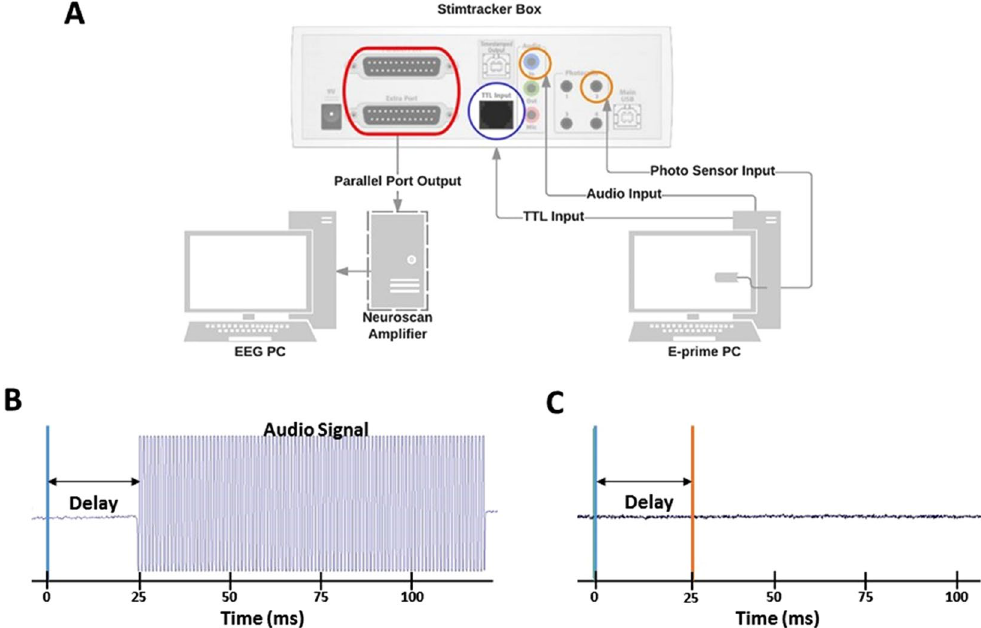
Figure 2. Measuring Time Delays in Task-based Multi-Site EEG Studies. ( A ) Setup of StimTracker system to measure the delay between the exact time of stimulus presentation (on E-Prime PC) and the time at which the stimulus onset was marked by the physiological data system (in EEG PC) (StimTracker diagram adapted from Cedrus website: http://cedrus.com/support/stimtracker/tn1460_st100_pins.htm) ( B ) Example of delay measurement when an audio signal is directly measured by the EEG system. ( C ) Example of auditory stimulus delay measurement with StimTracker system. The figure was drawn by authors using Lucidchart (Lucid Software Inc, UT,